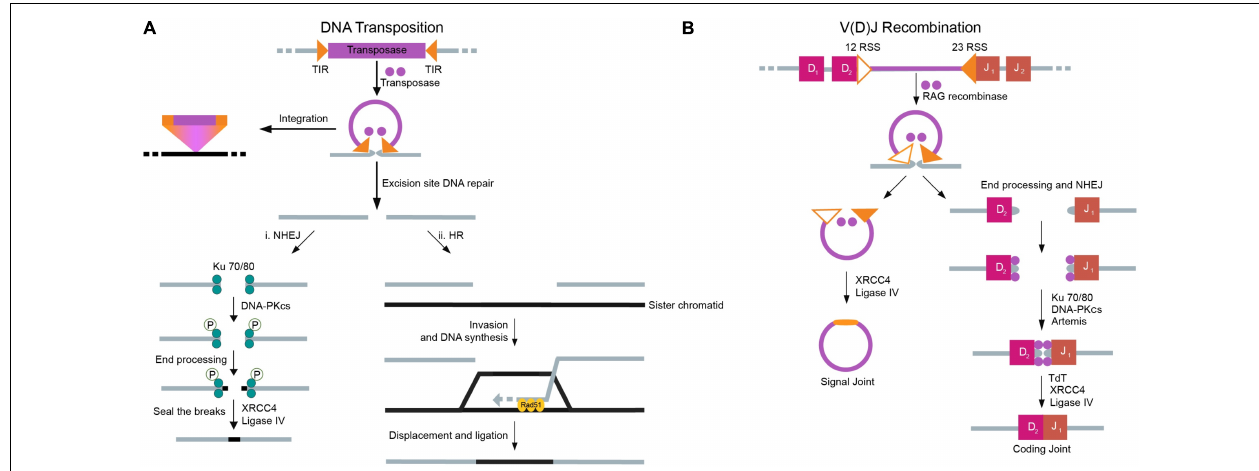
FIGURE 4 | Mechanisms of double-strand break repair for DNA transposition and V(D)J recombination. DNA repair occurs to seal double stranded breaks (DSBs) created in the donor strand due to DNA transposition and V(D)J recombination. (A) In DNA transposition, once the transposon has been excised, the DSB can be repaired using either NHEJ or HR, with preference generally given to NHEJ. (i) In NHEJ, the process starts with the binding of the Ku 70/80 heterodimer to the broken DNA ends. A phosphorylation cascade initiated by DNA PKcs results in the recruitment of various proteins in the NHEJ pathway that are responsible for both the stability of the DNA complex and end processing. Finally, DNA ligase IV and XRCC4 act to seal the breaks in the DNA strand. (ii) In the case of HR, a sister chromatid or homologous chromosome serves as a template to repair the DSB. The process is contingent on the DNA-binding activity of Rad51. After replication based on the template strand, the donor DNA reseals. (B) In V(D)J recombination, the DSB must be repaired using NHEJ. The NHEJ process in V(D)J recombination generally involves the same components as are used in the repair of DSBs caused by transposons. Proteins specific to the V(D)J recombination process are highlighted.